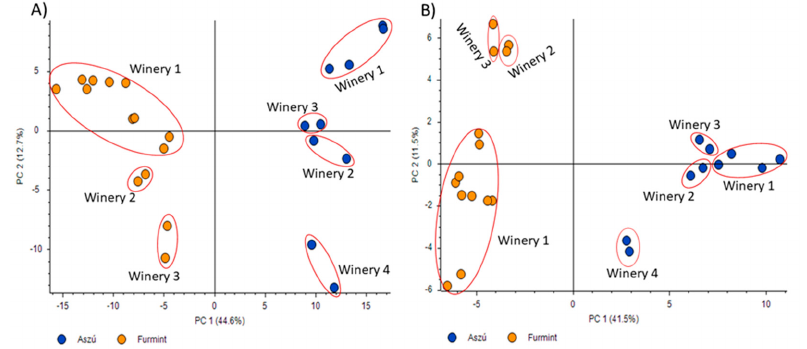
Figure 1. Principal component analysis of “aszú” and “furmint” wine samples analyzed in positive panel ( A ) and negative panel ( B ) polarity mode. The “x” axis shows PC1 while the “y” axis shows PC2. The orange dots represent the “furmint” samples while the blue dots represent the “aszú” samples. The wineries are also indicated with numbering.